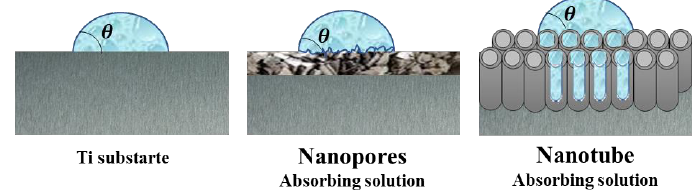
Figure 3 . Wettability in Ti Nanostructures. Figure 3. Wettability in Ti